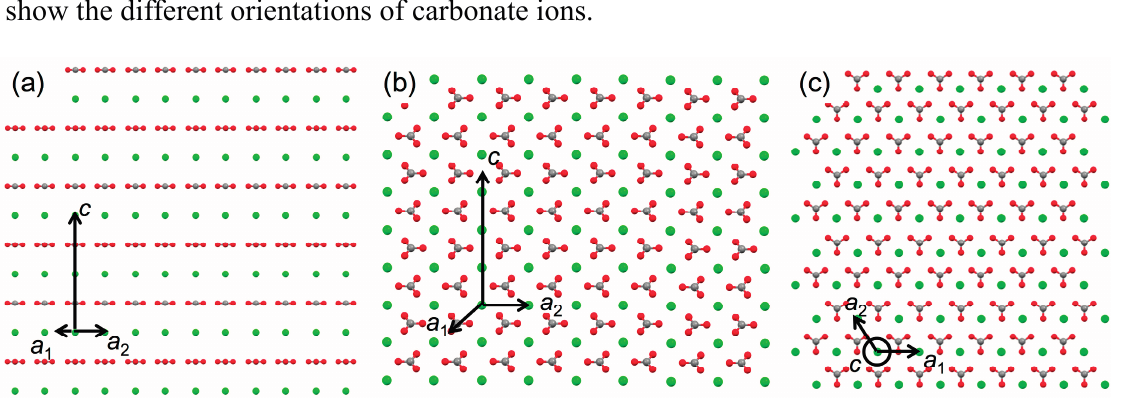
Figure 3. Molecular models of calcite (1 0 0) ( a ); (1 0 4) ( b ); and (0 0 1) ( c ) planes to show the different orientations of carbonate